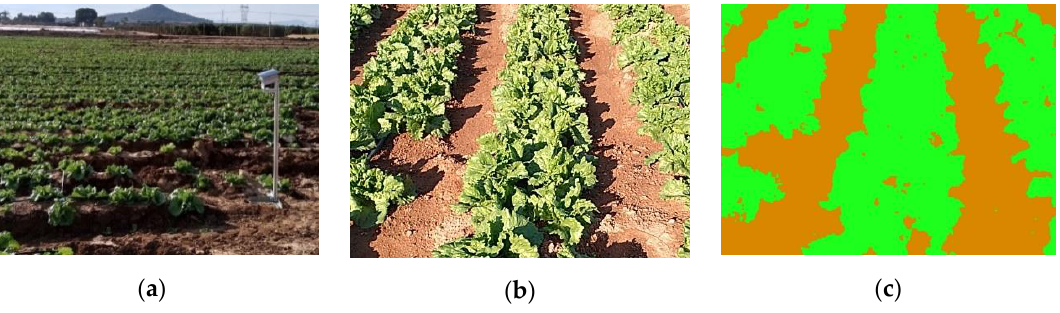
Figure 4. Sample images of the remote image system where the proposed method was integrated. ( a ) Global view of the lettuce crop and a remote image capture module. ( b ) Sample image captured by the remote module. ( c ) Segmentation of the previous image in plant and